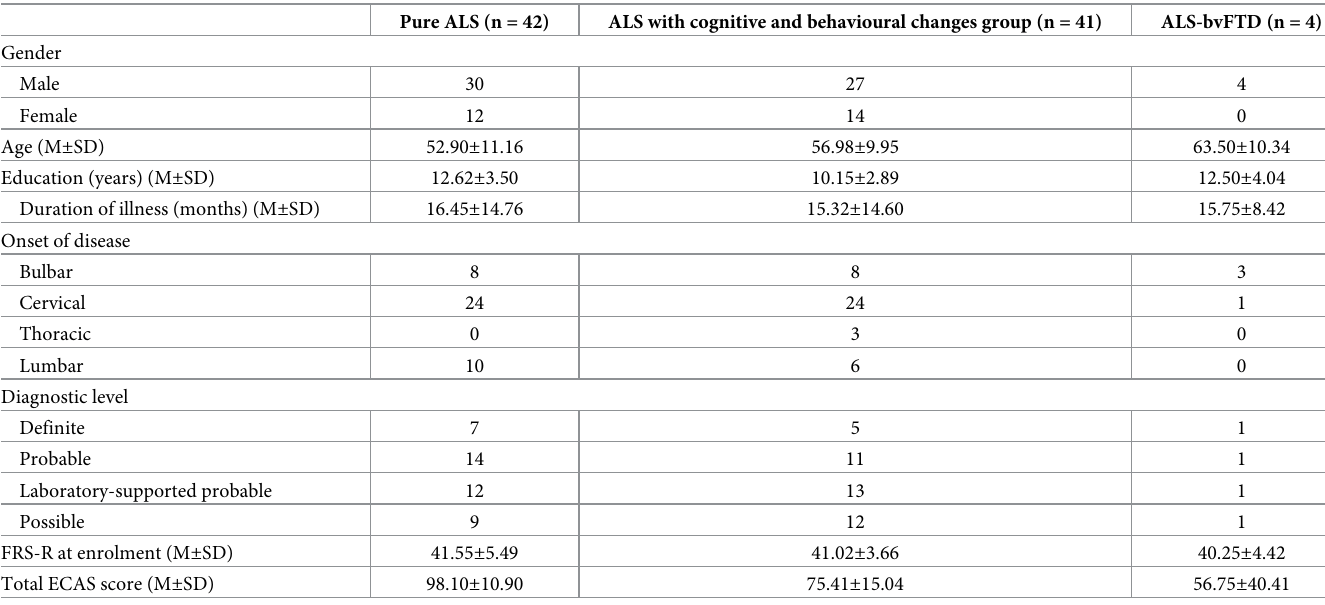
Table 1. Clinical information of 87 ALS patients.